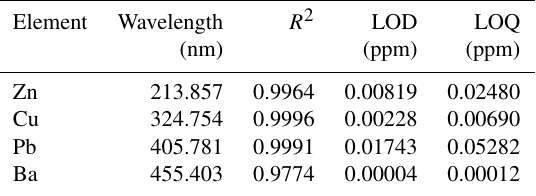
Table 3. Figures of merit from the MP-AES method representing the wavelength of detection, correlation coefficient ( R 2 ), limits of detection (LOD), and limits of quantitation (LOQ) of metals under